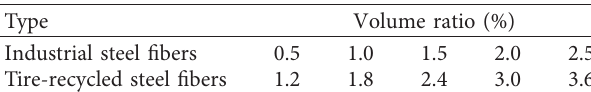
Table 6: The volume ratio of the two types of steel fibers.